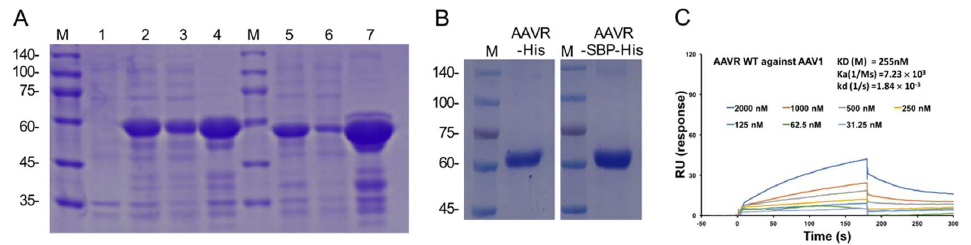
Figure 3. Preparation and characterization of recombinant AAVR proteins. ( A ) AAVR-His and AAVR-SBP-His proteins were expressed in E.coli. BL21 cells under IPTG induction. (lane 1, lysate from cells without IPTG treatments; 2, lysate of His-tagged AAVR (PKD1-5); 3, lysate supernatant from induced BL21; 4, pellet from AAVR-His expressing BL21; 5, lysate from AAVR-SBP-His expressing cells; 6, supernatant from AAVR-SBP-His positive BL21; 7, pellets from AAVR-SBP-His expressed cells. ( B ) AAVR-His or AAVR-SBP-His protein purified by nickel a ffi nity chromatography and additional gel filtration chromatography. ( C ) Purified AAVR recombinant protein bound to AAV virion with high a ffi nity. Soluble recombinant AAVR was tested for the binding to AAV1 capsid by BIAcore sensorgrams. The concentrations of the analytes in triplicates are indicated with the calculated association rate constant ( K a), and dissociation rate constant ( K d) and K D